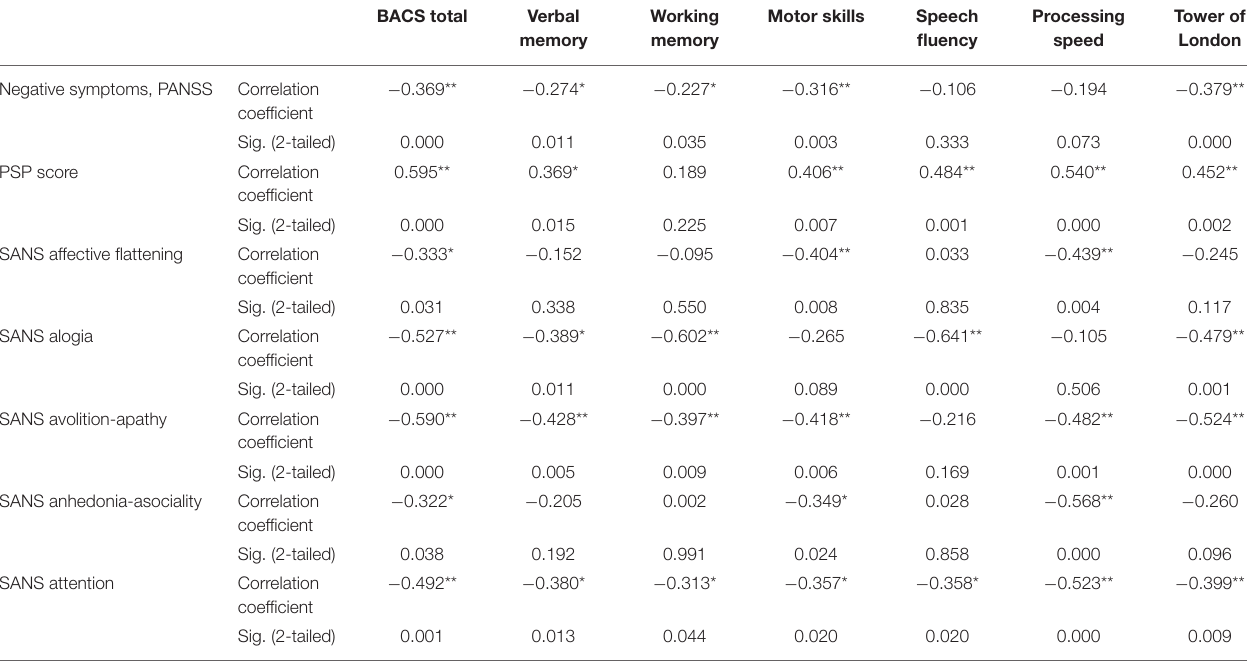
TABLE 4 | Correlation analysis of associations between BACS scores in clinical scales scores in the sample.